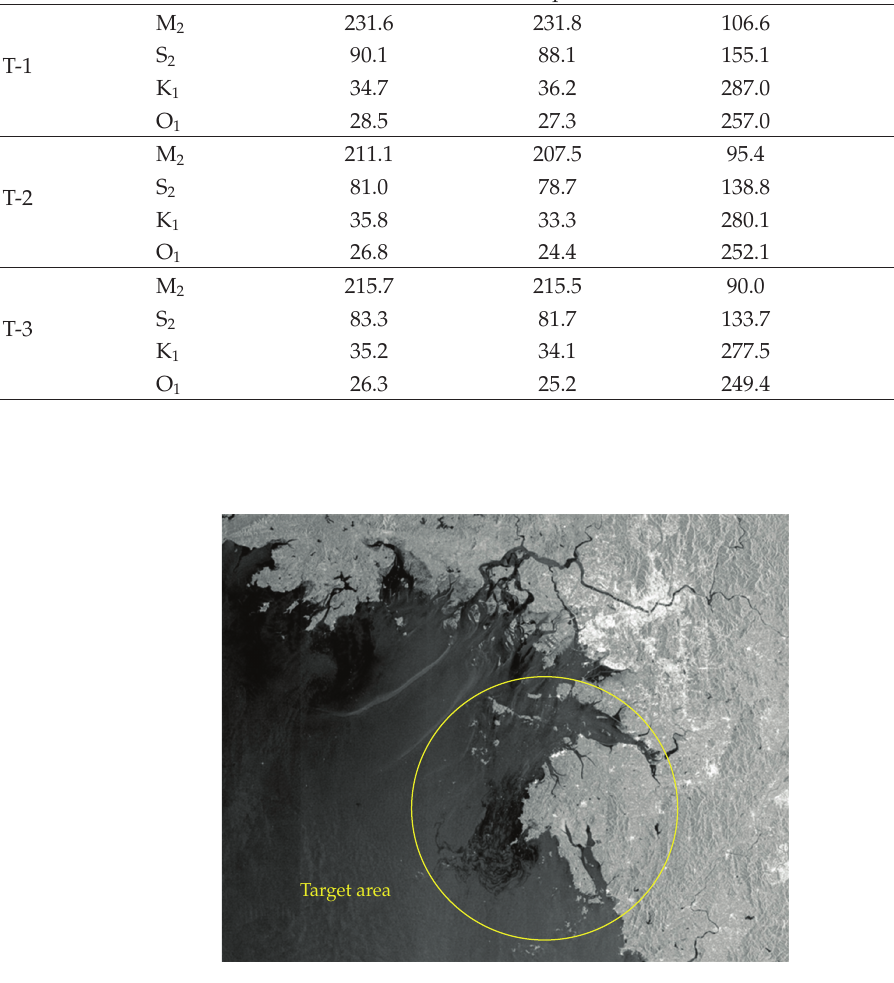
Figure 7: Satellite image of the Hebei Spirit oil spill (cid:6) December 11, 2007 (cid:7)